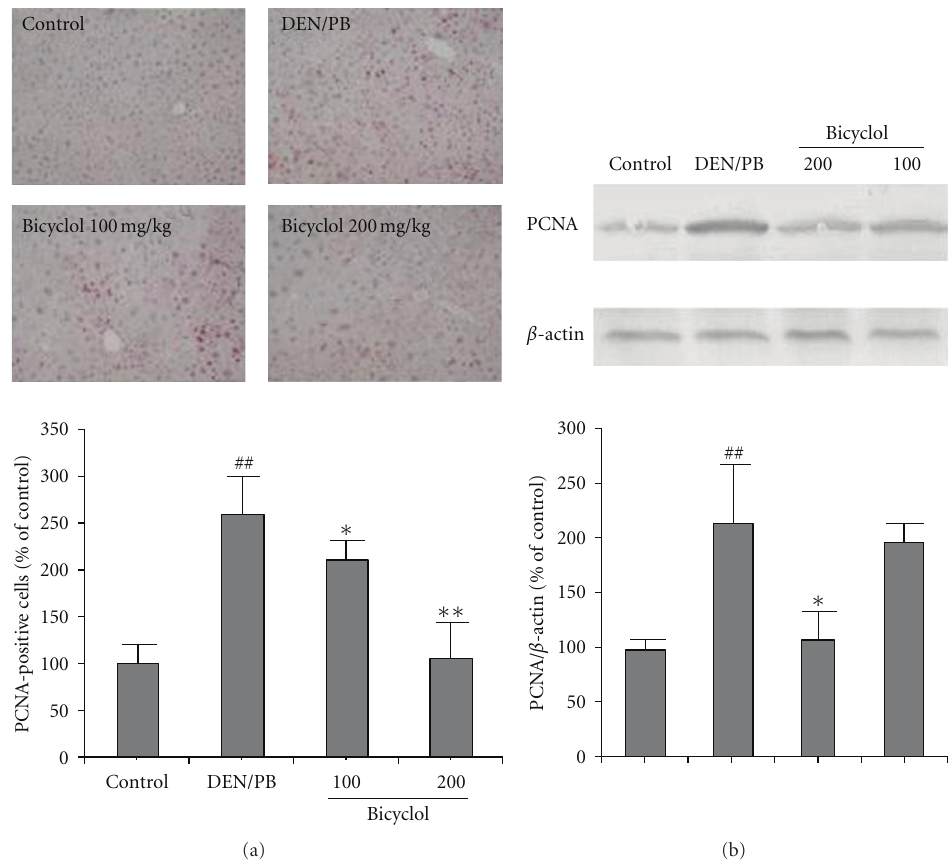
Figure 6: Expression of PCNA in the control and experimental groups at week 20. (a) Representative microscopic pictures of PCNA-stained liver sections by immunohistochemical analysis (100 × ) and quantification of the immunostained section of PCNA. ## P < 0 . 01 compared with the control group; ∗ P < 0 . 05, ∗∗ P < 0 . 01 compared with the DEN/PB model group. (b) Western blot assay of PCNA and the quantitative results obtained by measuring the optical density of each band and expressed as the ratio of each targeted protein and beta-actin. Average values of 3 separate experiments along with the standard deviations are shown. ## P < 0 . 01 compared with the control group; ∗ P < 0 . 05 compared with the DEN/PB model